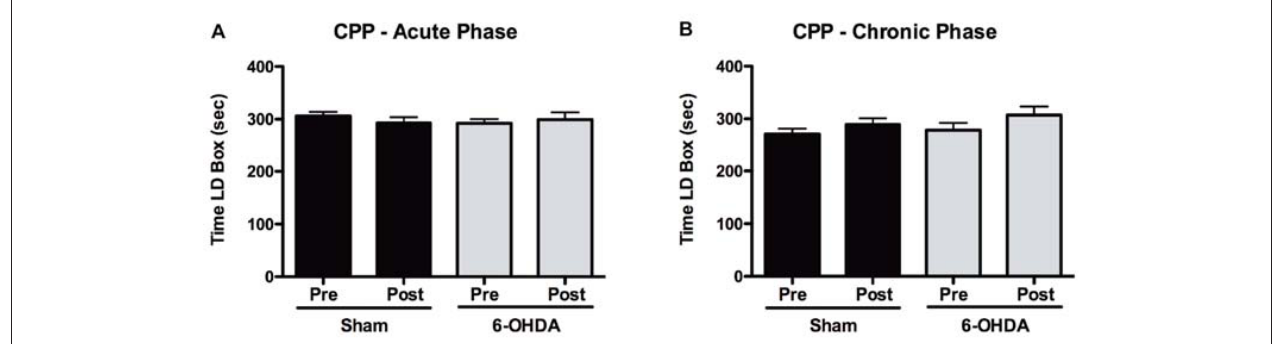
FIGURE 5 | Assessment of positive reinforcement of acute and chronic LD treatments with the CPP. (A) Time spent in the LD-paired box during pre and post conditioning stages of the CPP for both sham ( n = 15) and 6-OHDA-lesioned animals ( n = 17), after acute LD treatment. (B) Time spent in the LD-paired box during pre and post conditioning stages of the CPP for both sham ( n = 16) and 6-OHDA-lesioned animals ( n = 16), after exposure to a period of chronic LD. Data presented as mean ±